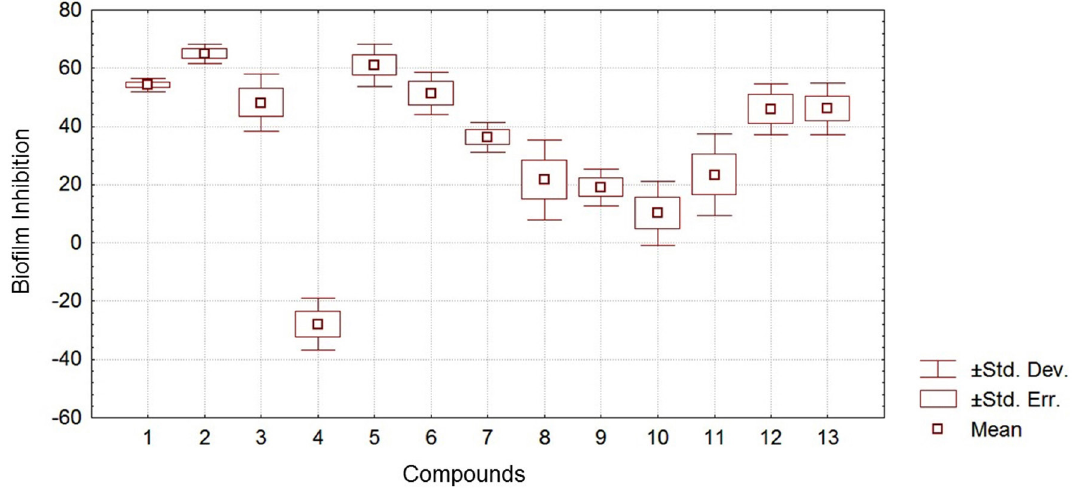
Figure 4- Statistical results for each compound on inhibition of biofilm formation obtained by ANOVA